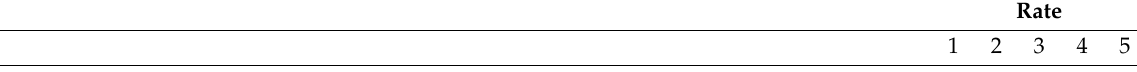
Table 2. Example of User Acceptance